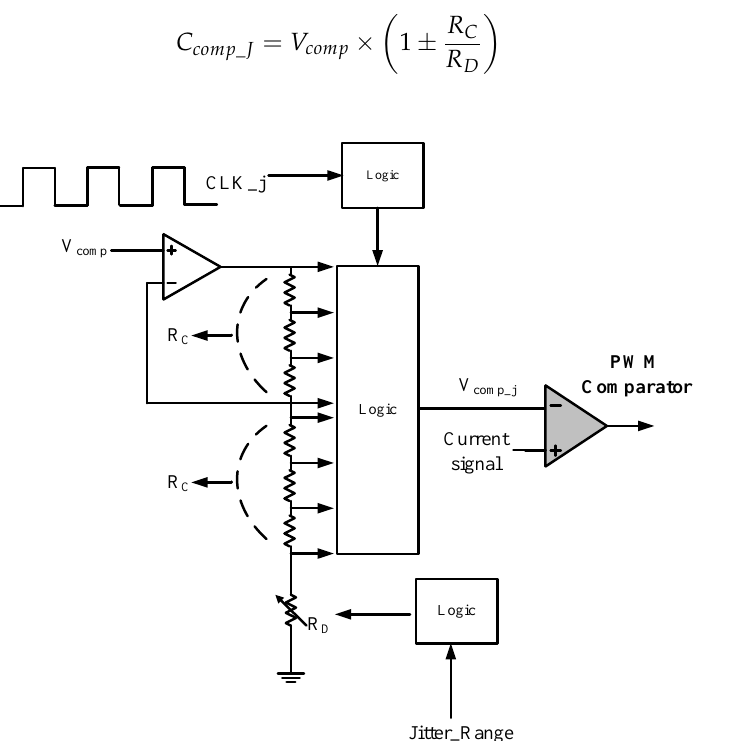
Figure 13. Frequency swapping logic circuit.